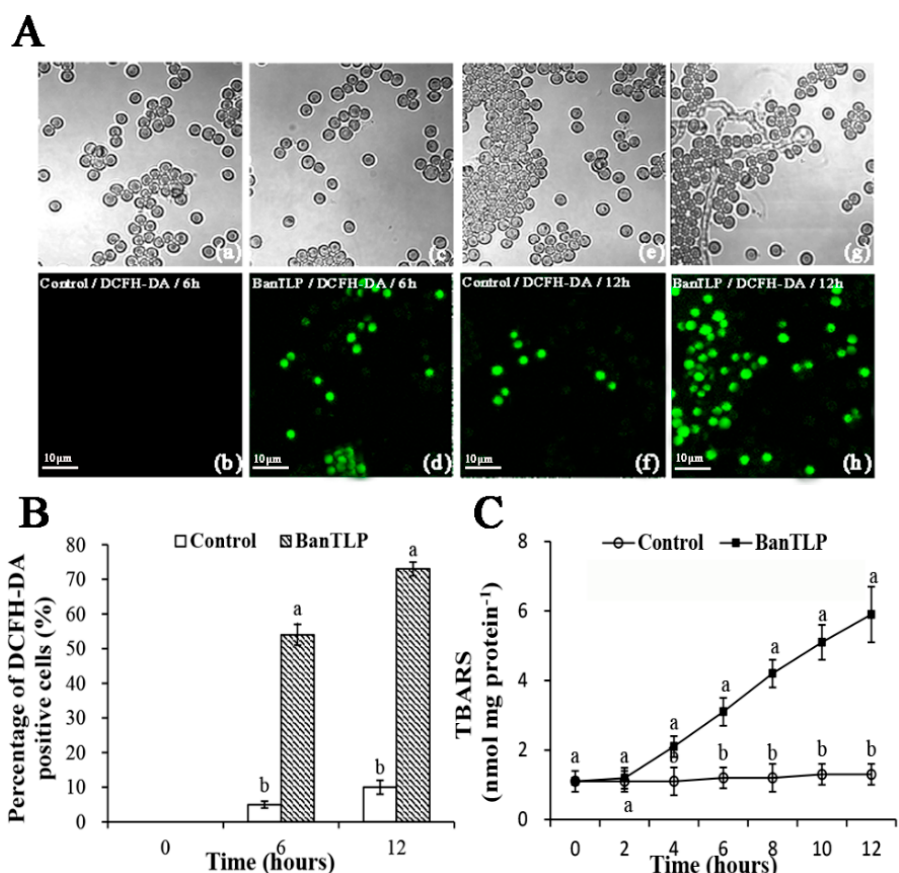
Figure 4. Effects of BanTLP at 60 μ M on oxidative stress of P. expansum. Figures panels show images of ( A ) the generation of intracellular reactive oxygen species (ROS), ( B ) the percentage of 2 ′ ,7 ′ - dichlorofluorescein diacetate (DCFH-DA) positive cells, and ( C ) thiobarbituric acid-reactive species (TBARS) contents. The DCFH-DA fluorescent probe was visualized with the aid of fluorescence microscopy in P. expansum conidia treated with distilled water for 6 h ( a , b ) and 12 h ( e , f ) or treated with BanTLP for 6 h ( c , d ) and 12 h ( g , h ). Upper panels display the bright field images, while lower panels display the corresponding fluorescence images for the same field. The scale bar represents 10 μ m. Each value is mean of three replicates for two independent experiments. Vertical bars represent standard deviations of means. Those data marked with different letters are significantly different ( p < 0.05) between control and treatment groups at the same time according to Duncan’s multiple range test.